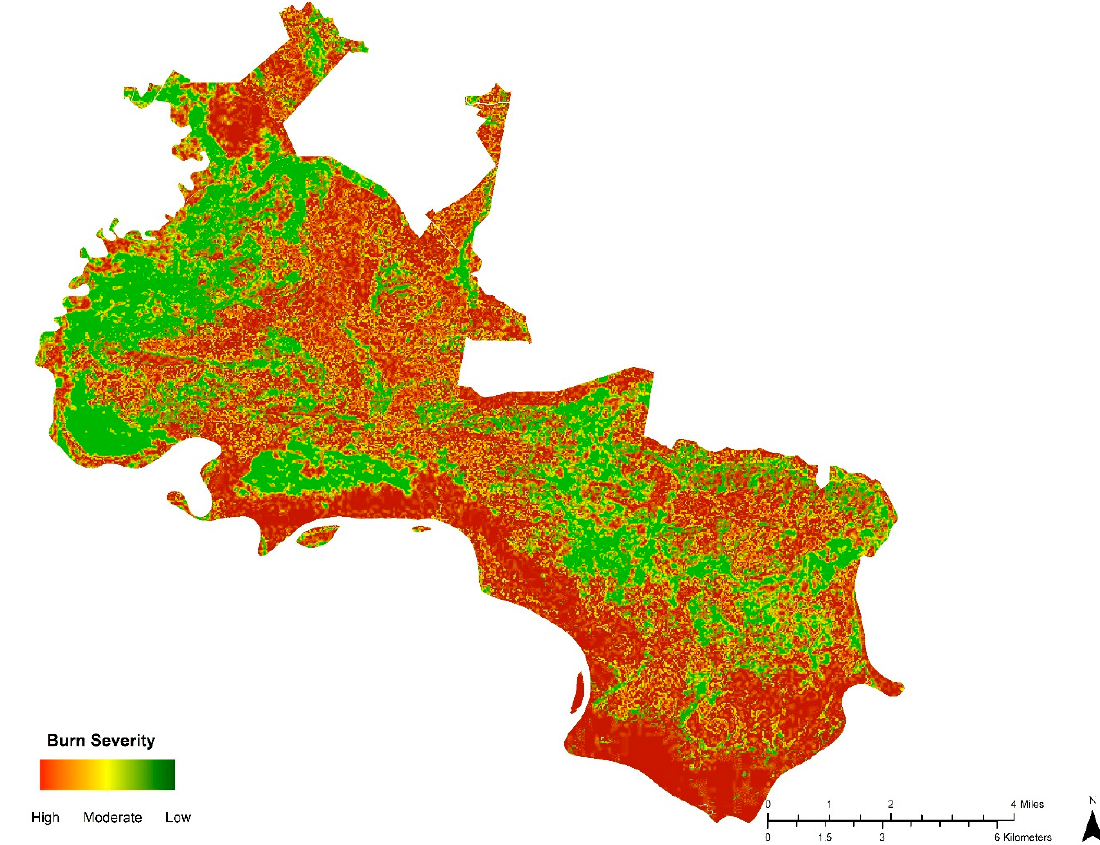
Figure 6. Thematic burn severity layer of Palo Verde National Park (PVNP) derived from RdNBR depicting severity as low, moderate, high; Transition areas between the zones are also noticed. Table 1. Values derived from dNBR indicating burn severity and classified based on the USGS Fire Effects Monitoring and Inventory Protocol (FireMON) program [17].